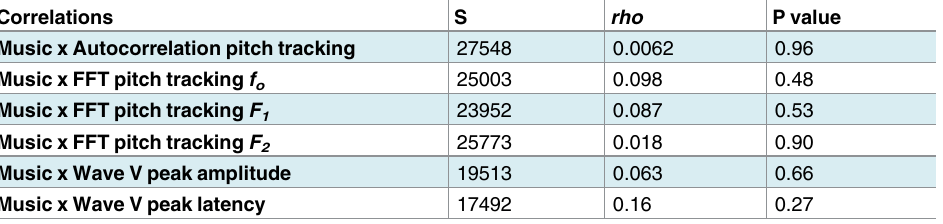
Table 7. Correlations between Gold-MSI generalized musical sophistication score and subcortical effect.